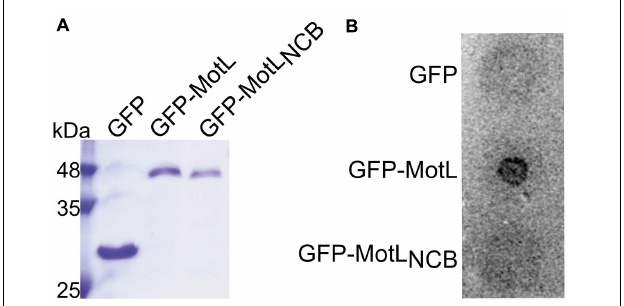
FIGURE 2 | MotL is a c-di-GMP-binding protein. (A) Purification of MotL. Shown is a Coomassie-stained SDS gel after separation of His-tagged purified GFP, GFP-MotL, and GFP-MotL NCB . (B) MotL binds c-di-GMP. Purified protein was applied to a membrane as indicated and exposed to radioactively labeled c-di-GMP. Only the MotL with the predicted binding site is able to bind and retain